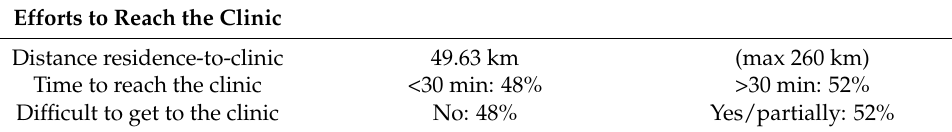
Table 2. Efforts necessary to reach the clinic. Efforts to Reach the